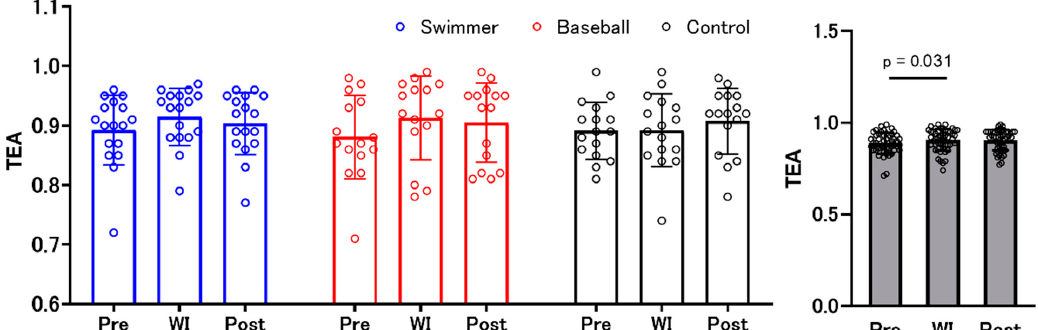
Figure 4. Changes in time estimation accuracy. Blue, red, and black bars indicate the swimmer, baseball, and control groups, respectively. There was no significant difference among the groups. Gray bars represent all participants with individual data (open circles). Time estimation accuracy (TEA) was significantly higher during water immersion (WI) than before WI (pre-WI).